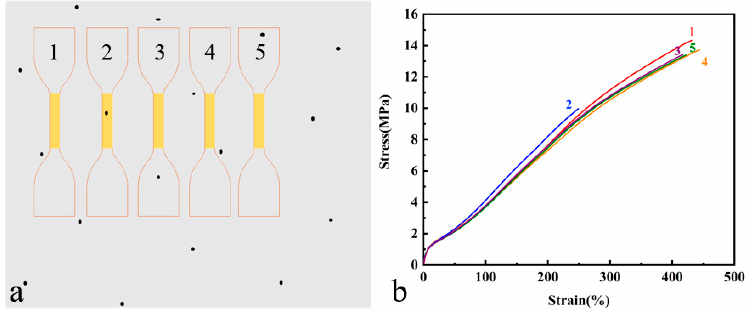
Figure 9. ( a ) Schematic diagram of the distribution of crack precursors on vulcanized rubber sheet ( b ) Stress–strain curves of the five samples under simple tension.